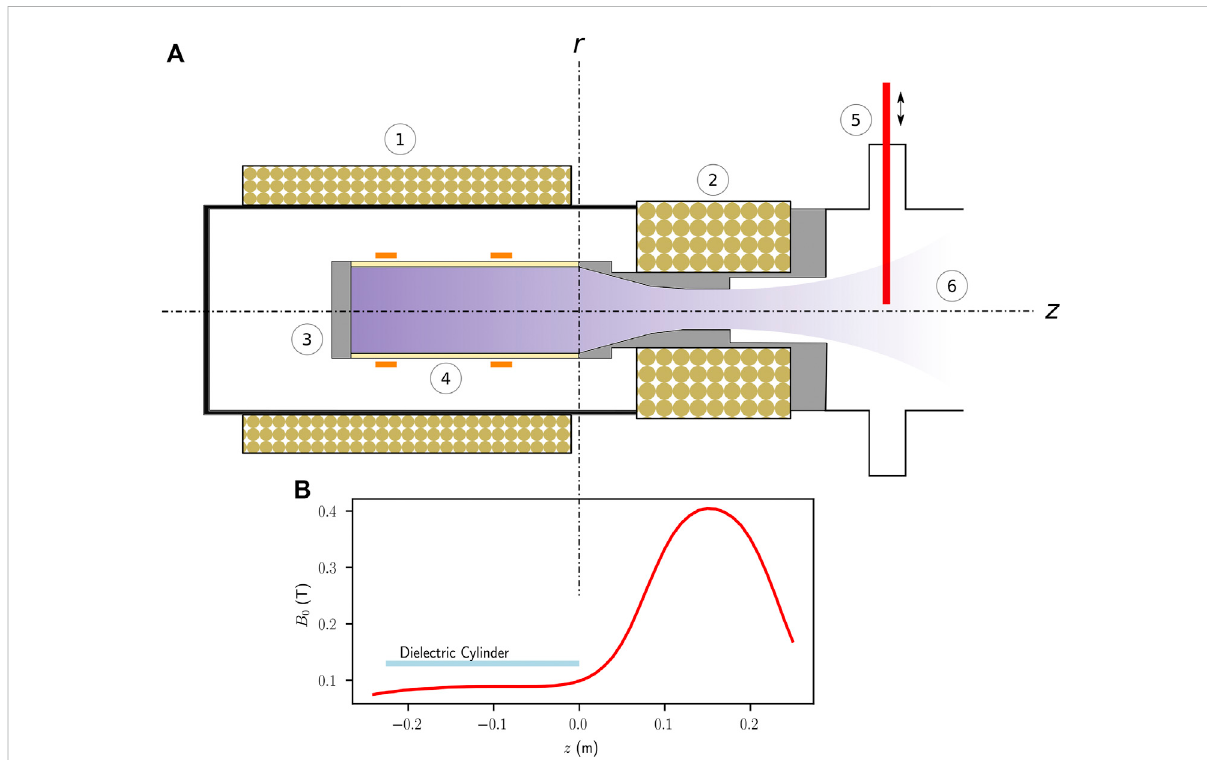
FIGURE 6 (A) Diagram of the VX-CR research helicon device. The axial magnetic fi eld is produced through two solenoid coils, 1 in the HPS region and 2 located downstream of the source. The HPS itself is located inside a high-vacuum chamber to prevent arcing from the voltages present in the RF subsystem.3representstheupstreamdielectricboundaryofthesourceandthisisthepointwheregasinjectionoccurs(notshown).4representsthe dielectric cylindrical boundary of the HPS, as well as the approximate location of the helicon antenna straps. 5 marks the location of a reciprocating Langmuir probe used to obtain ion current density and plasma density readings. 6 describes the downstream section of the HPS, interfaced to a vacuum chamber and a pumping system (not shown). (B) Experimental measurements of the magnetic fi eld intensity B 0 at the HPS axisasafunctionofthe z axialposition.ThecoordinatesystemhasitsoriginattheexitboundaryoftheHPSdielectriccylindricalboundary,following the convention established in section 2.2. Measurement uncertainties for the values of B 0 are less or equal than 0.0008 T .